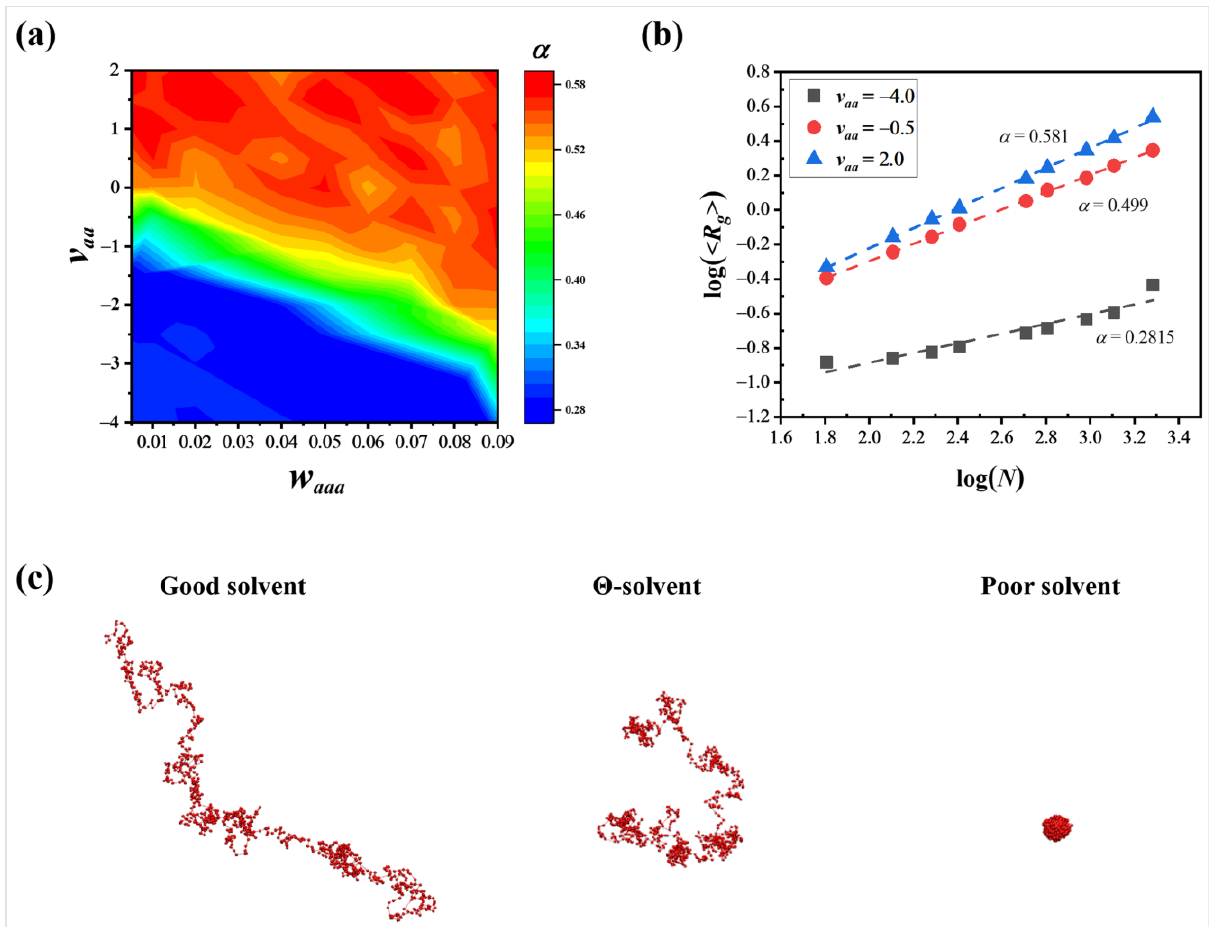
Figure 1. Relationships of model parameters and solvent quality obtained from single chain scaling analysis. ( a ) Colormap of the scaling exponent, α , in the power-law relationship R g ∝ N α , which is extracted from single-chain MC-GL simulations of various chain lengths, N , for given sets of virial coefficients ( v aa , w aaa ); ( b ) measured radius of gyrations, R g , vs. N in the range 64 to 1960 (log scale) for three different values of v aa = − 4.0, − 0.5 and 2 with w aaa fixed at 0.02. The scaling exponent, α , for each pair of v aa and w aaa is estimated by fitting the data linearly. The fitted lines and estimated α values are shown as well; ( c ) representative chain conformations after equilibration of MC-GL simulations of a single chain ( N = 960) under good, Θ , and poor solvent conditions; the ( v aa , w aaa ) values are (2.0, 0.02), ( − 0.5, 0.02), and ( − 3.0, 0.02) for the good, Θ , and poor solvent conditions, respectively. Measured < R g > are 2.13, 1.54, and 0.26 ( R e ) for a single chain under the good, Θ , and poor solvent conditions,